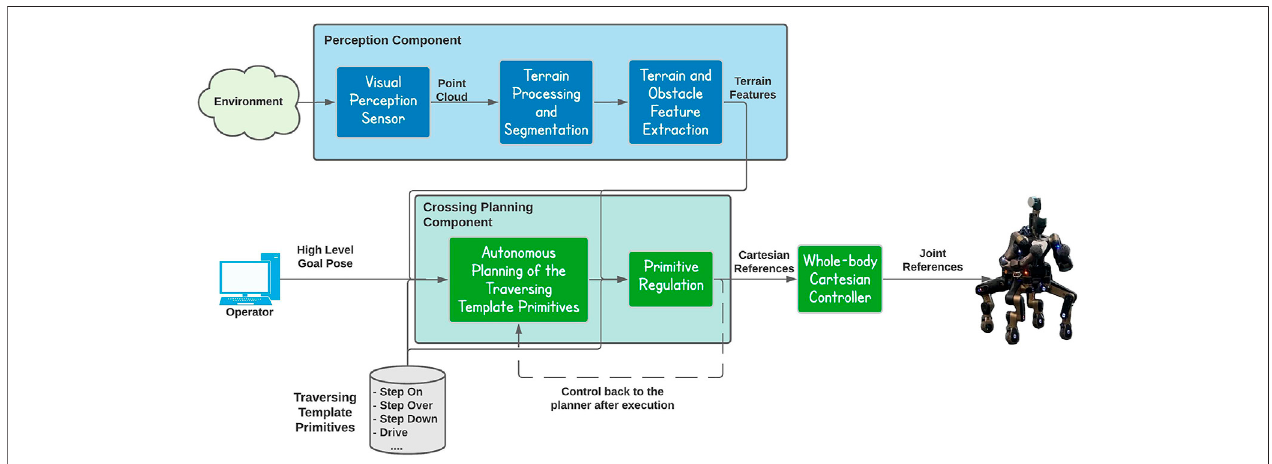
FIGURE1| The proposed autonomousobstacle crossing frameworkcomposed by twocorecomponents,the Perception componentand theCrossingPlanning component.